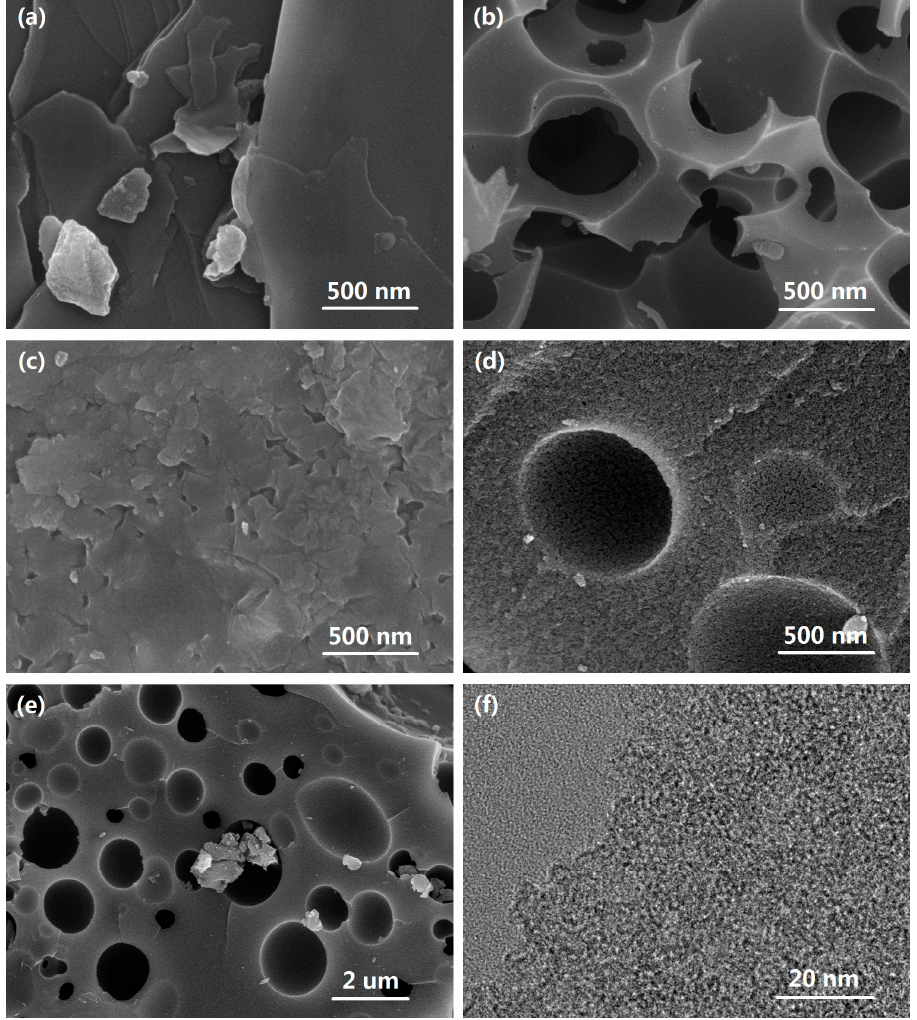
Figure 3. SEM images of ( a ) PR, ( b ) PRK3, ( c ) PRN1, and ( d , e ) PRK3N1 with different magnifications, and ( f ) TEM image of PRK3N1.